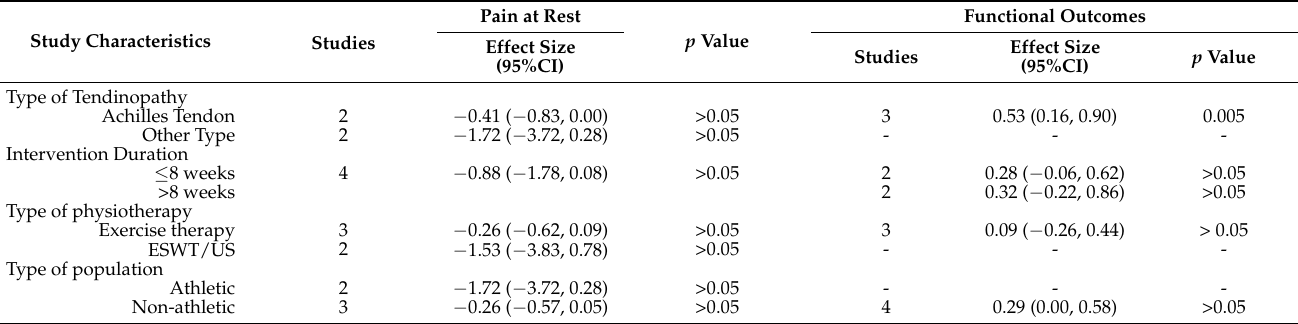
Table 4. Results of subgroup analysis.